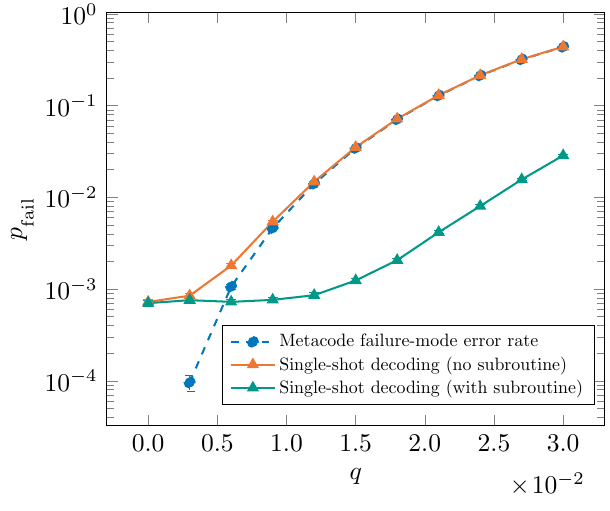
FIG. 2. Single-shot decoding of the 3D toric code with L = 5, with and without the metacode failure-mode subroutine. The fail- ure rate p fail is plotted against increasing values of the syndrome error rate q , whilst the phase-flip error rate is set to p = 0.1. With- out the subroutine, the single-shot decoder rapidly converges to the failure-mode error rate (dotted line). For large values of q the subroutine improves the logical failure rate by over an order of magnitude. In this simulation, BP+OSD is used for both stage-1 and stage-2